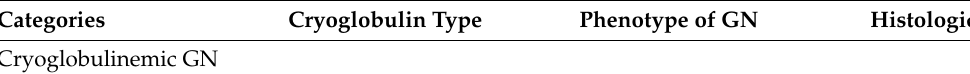
Table 4. Several mechanisms of HCV-associated kidney